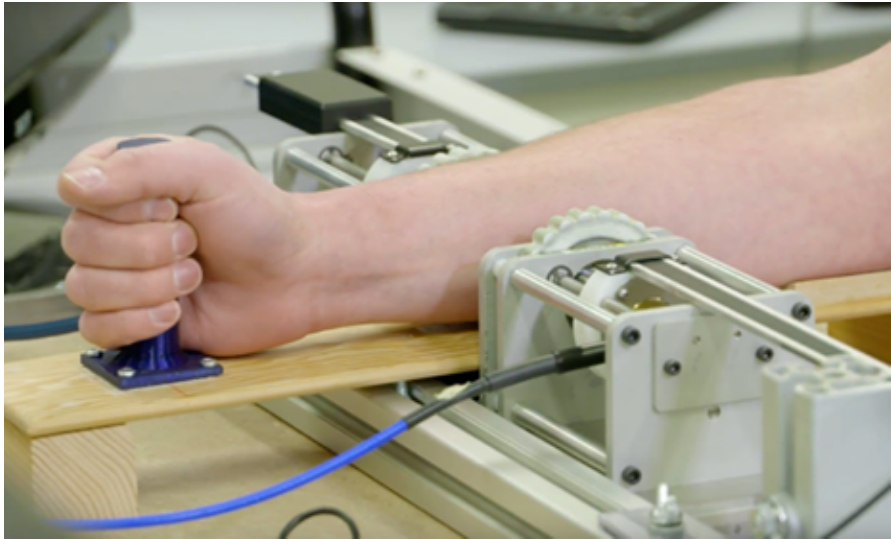
Figure 1. Measurement system. ©2019 IEEE. Reprinted, with permission, from IEEE Journal of Electromagnetics, RF and Microwaves in Medicine and